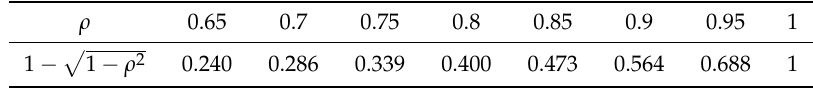
(cid:112) Table 3. Proportion 1 − 1 − ρ 2 of the standard deviation of cash flow injections that can be eliminated through a local minimal variance hedge for a correlation between the mutual fund and the hedging asset of ρ